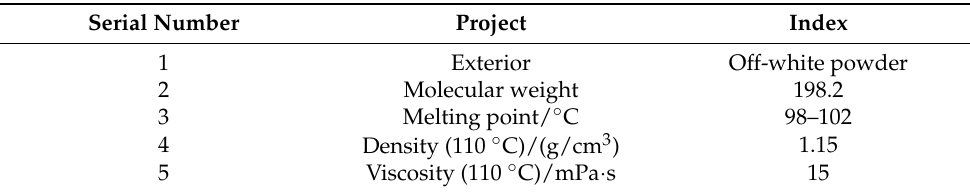
Table 5. Physicochemical properties of HQEE.